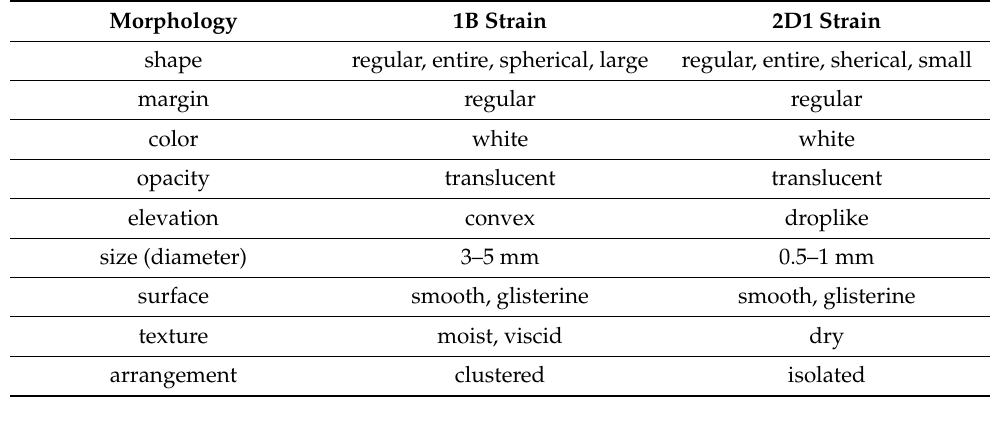
Table 1. Morphological characteristics of the strains 1B and 2D1.